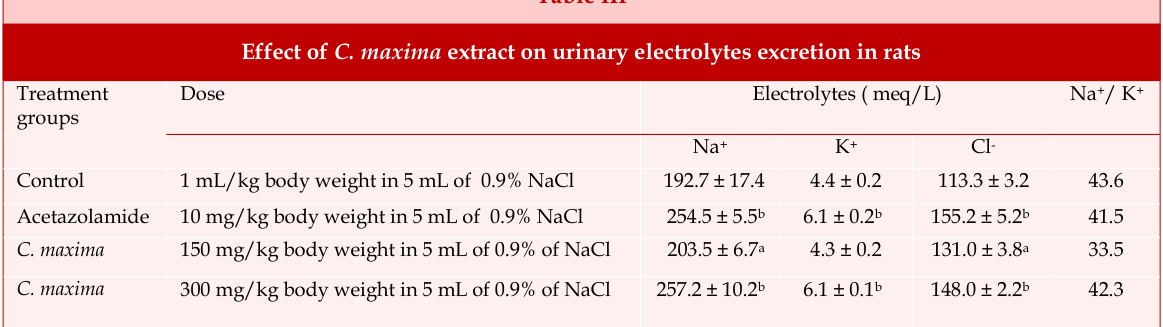
Effect of C. maxima extract on urinary electrolytes excretion in